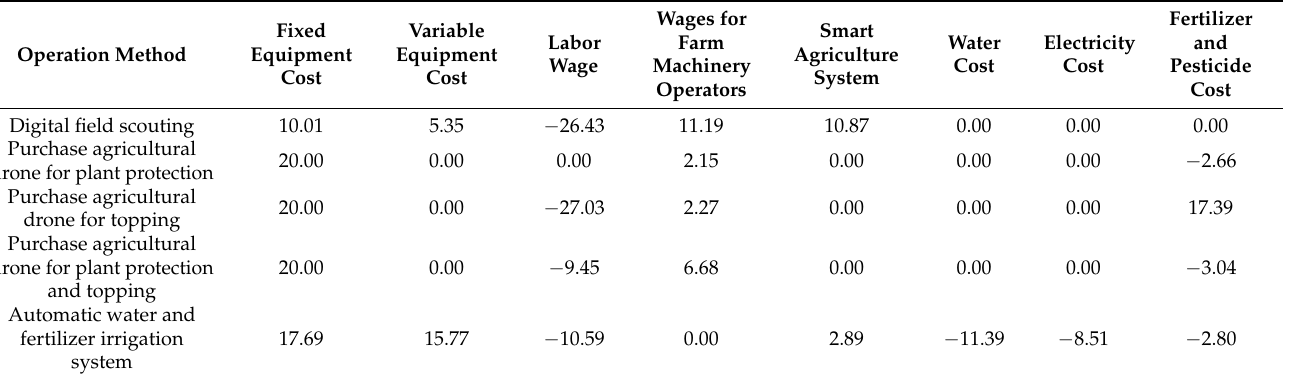
Table 6. Percentage change in the degree of change in the critical planting size corresponding to a 20% increase in the factors influencing the digital management of cotton